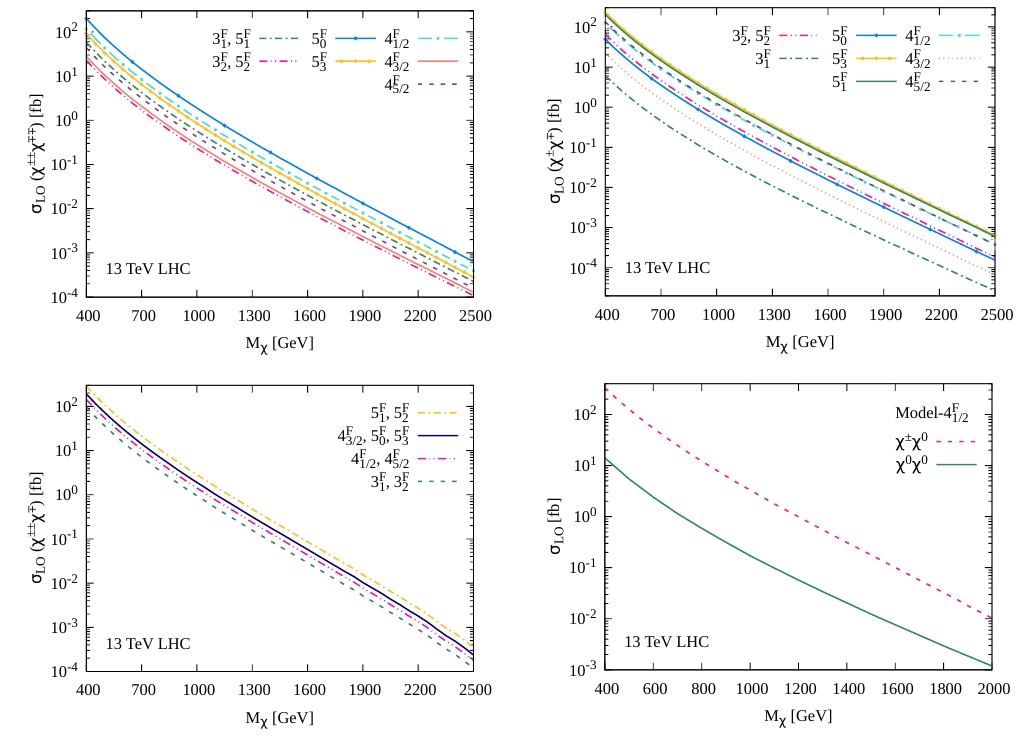
Figure 2 . LO production cross-sections of the exotics in different simplified models: doubly-charged pair production (top left), singly-charged pair production (top right), doubly- and singly-charged as- sociated production (bottom left), and neutral pair and neutral-charged productions (bottom